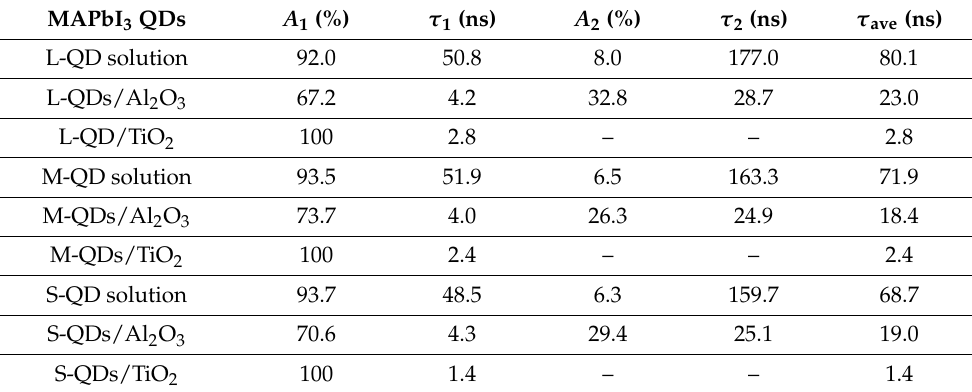
Figure 6. Time-resolved photoluminescence (TRPL) decay of ( a ) large, ( b ) medium, ( c ) small MAPbI 3 QD solution, adsorbed on TiO 2 and Al 2 O 3 . Table 2. The fitted parameters of TRPL decay profiles for various sizes of MAPbI 3 QD solution, QDs/TiO 2 and QDs/Al 2 O 3 . The decay curves were fitted by a biexponential ( y = A 1 exp ( − t / τ 1 ) + A 2 exp ( − t / τ 2 )) and single-exponential model ( y = A 1 exp ( − t / τ 1 )), where A 1 and A 2 are constant, τ 1 and τ 2 represent lifetime, t is time. τ ave is average lifetime calculated by τ ave = .